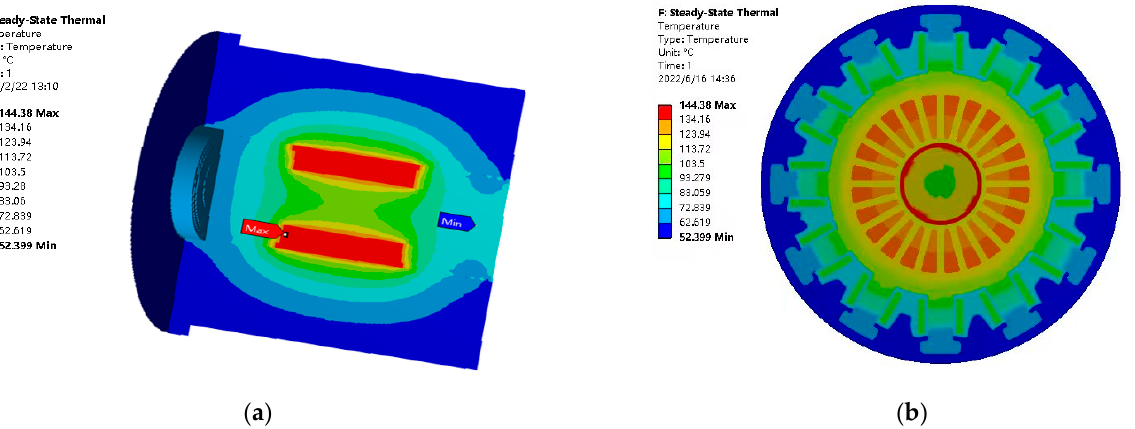
Figure 26. Thermal distribution of coupled magnetic fluid thermal fields at rated speed: ( a ) Axial 3D section of temperature distribution of motor; ( b ) Radial section of temperature distribution of motor.